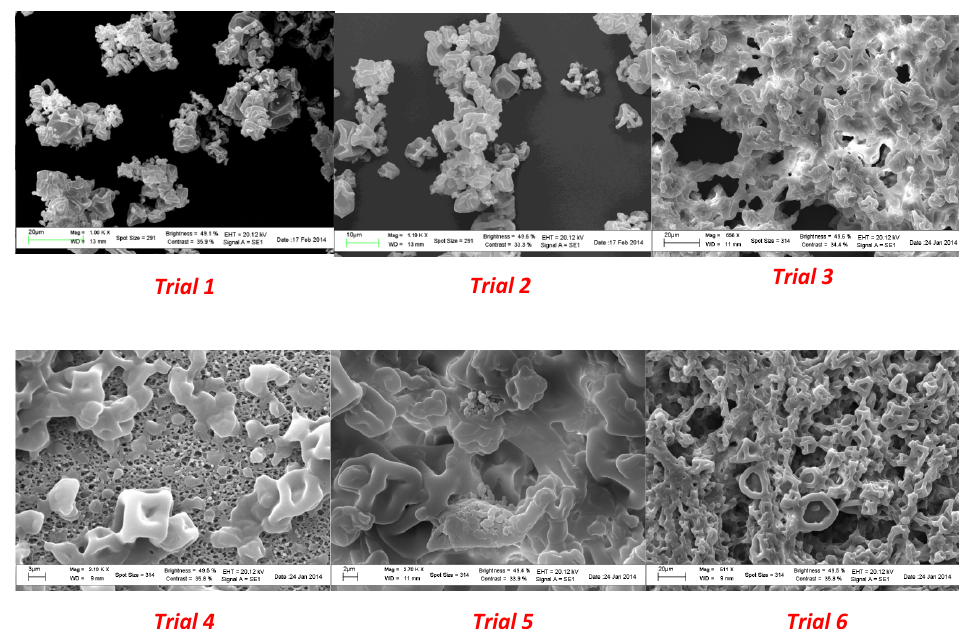
Figure 4. SEM images of microparticles from spray drying experiments after 2 h in an aqueous en- vironment.